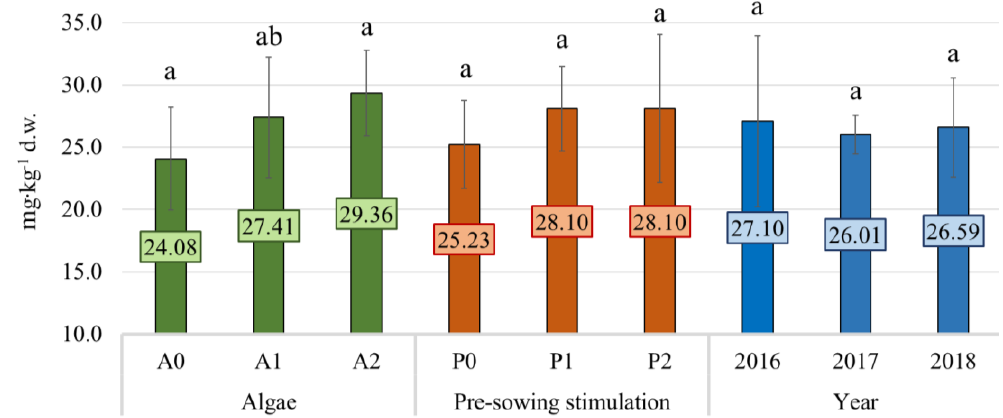
Figure 10. The mean sodium content (mg ⋅ kg −1 ) in oat grains in 2016–2018 depending on the experimental factors used. According to Tukey’s HSD test, the means marked with the same letter are not significantly different at α ≤ 0.05.